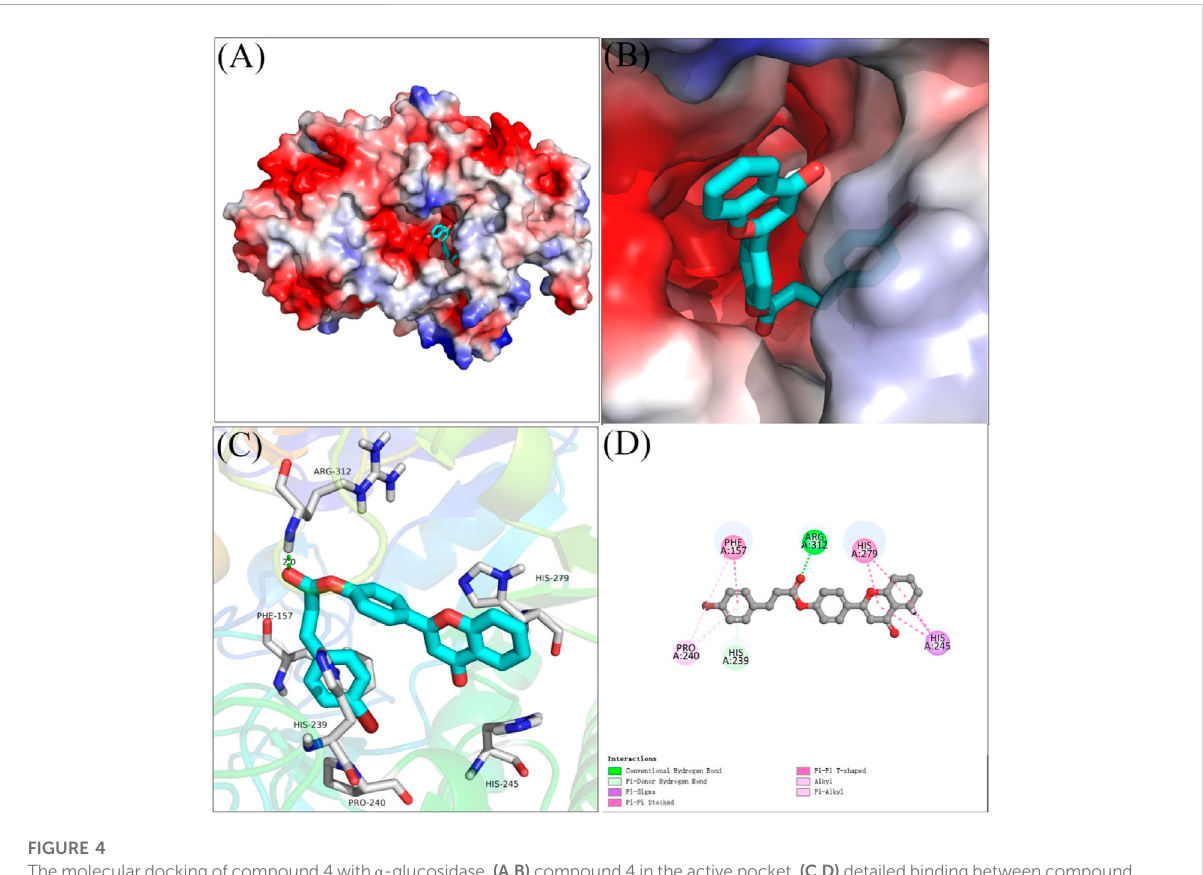
FIGURE 4 The molecular docking of compound 4 with α -glucosidase. (A,B) compound 4 in the active pocket. (C,D) detailed binding between compound 4 and enzyem.